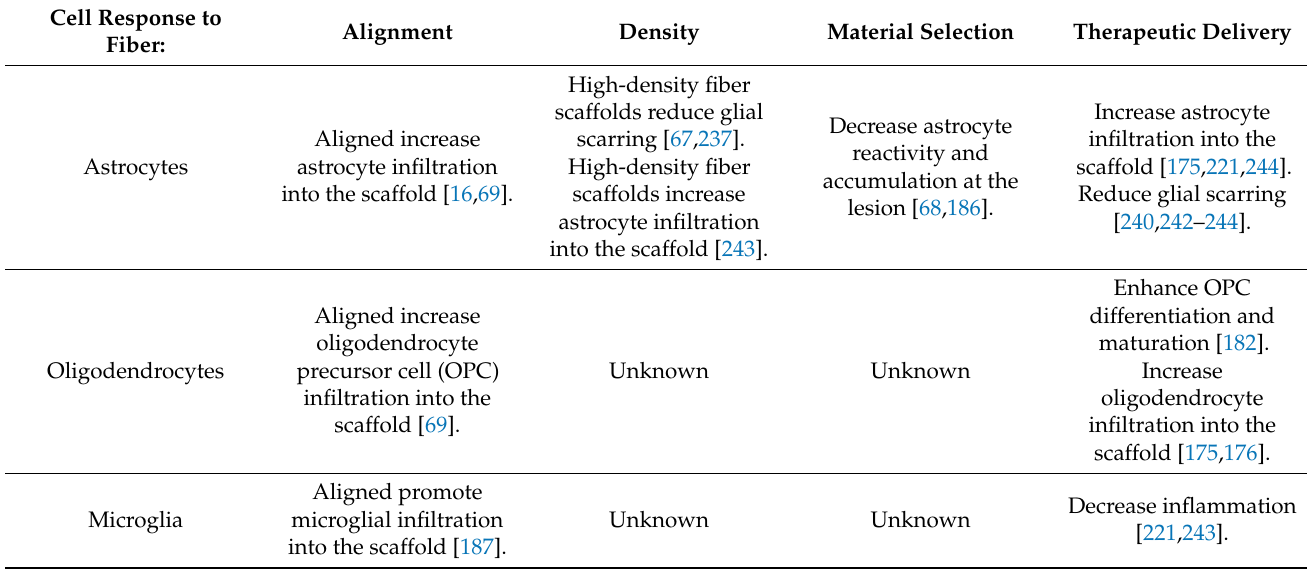
Table 5. Summary of central nervous system glia response to various electrospun fiber properties in vivo. Cell Response